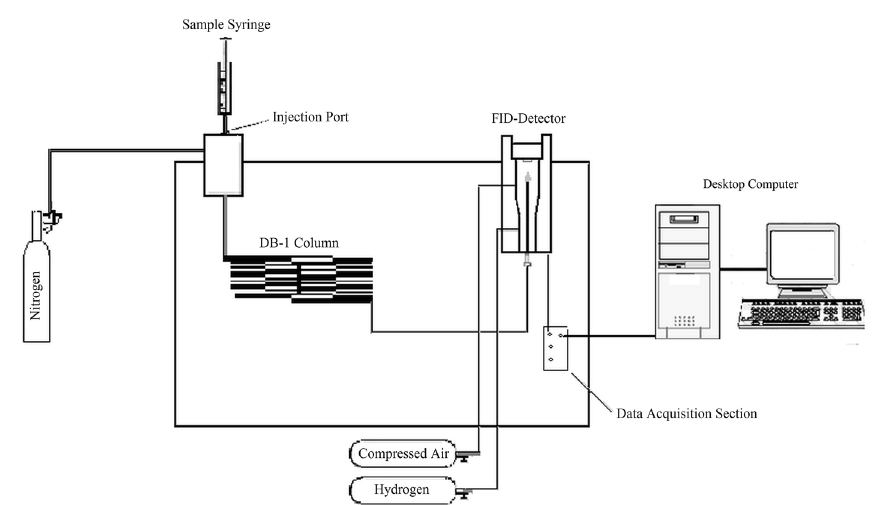
Fig. 6 Schematic of the GC- FID